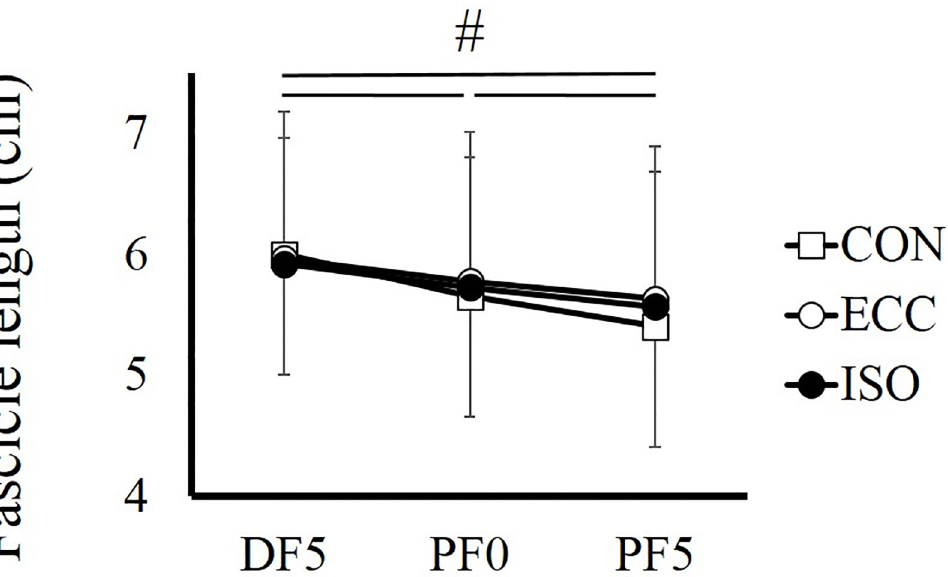
Fig 7. Fascicle length recorded at DF5°, PF0°, and PF5° in CON, ECC, and ISO conditions. # indicates a significant difference among joint angles ( P < 0.05). CON; concentric contraction without preliminary contraction, ECC; concentric contraction after preliminary eccentric contraction, ISO;